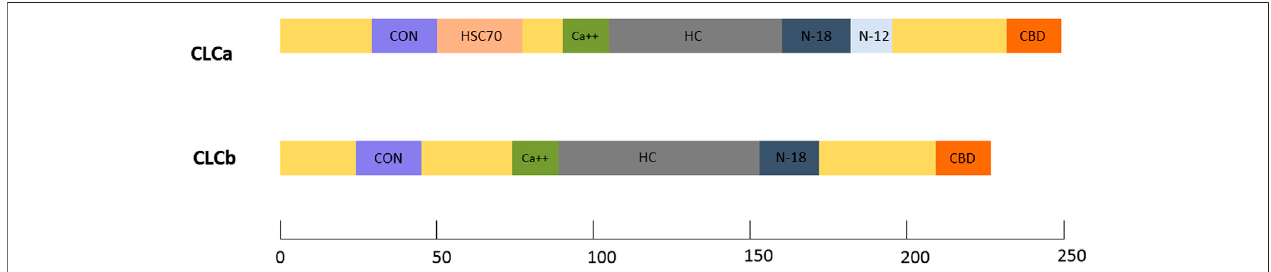
FIGURE 1 | CLC protein domains: Domain maps of the vertebrate CLCs, CLCa and CLCb. Common functional domains indicated include the consensus sequence (CON) shared by all vertebrate CLCs, the calcium-binding sequence (Ca++), the heavy chain-binding region (HC), the neuronal inserts of 18(N-18) and 12(N- 12) residues, and the calmodulin-binding domain (CBD). Unique to CLCa is a region that can stimulate the uncoating ATPase, HSC70, in vitro .